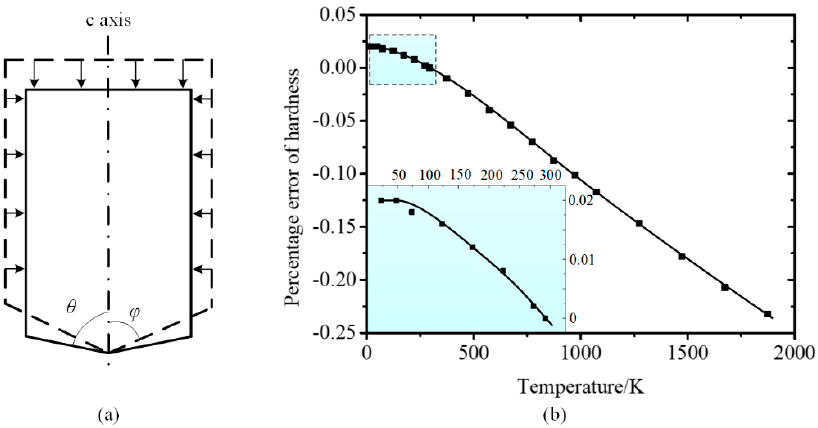
Figure 13. ( a ) Thermal deformation of sapphire indenter at low temperatures. ( b ) Percentage error of hardness at different temperatures [33].